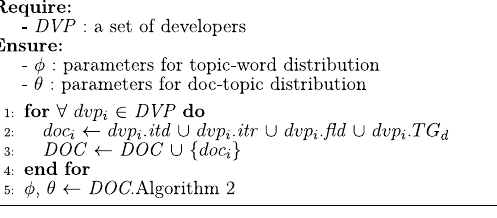
Algorithm 3. Developer topic model